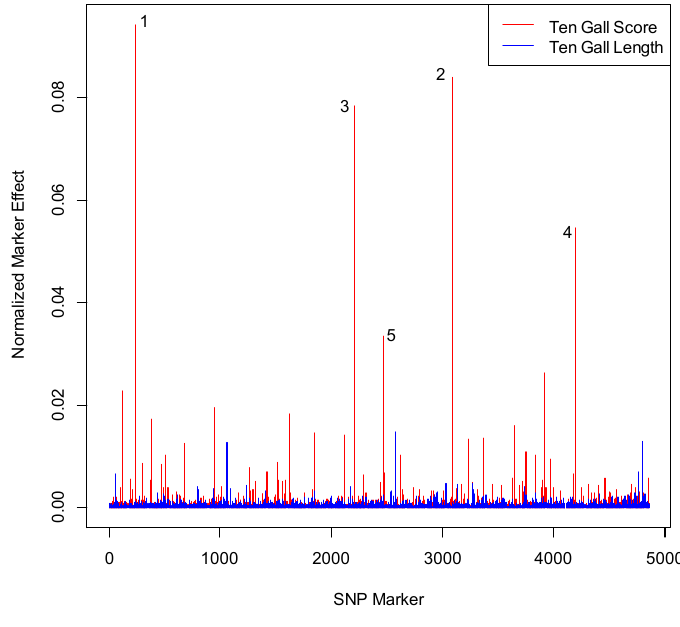
Figure 1. Comparative magnitude of the normalized effects (absolute values) for gall score (red markers) and gall length (blue markers) obtained using Bayes C  in the 10 gall datasets. SNP markers are represented by a single line and are in alphanumerical order. Numbers correspond to ranking of the top five SNPs with largest effects on gall score in the 10 gall dataset (See Figure S1 for identification of the top-ranked